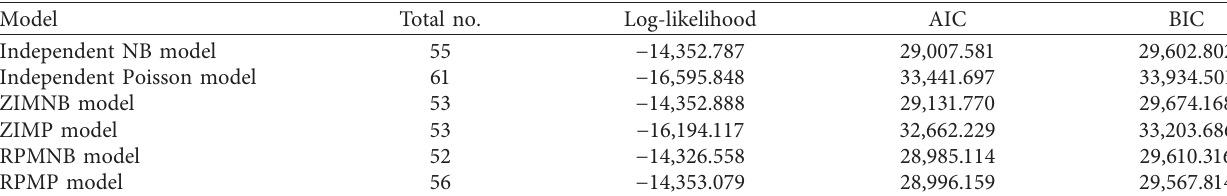
Table 5: Goodness-of-fit measure of six models.